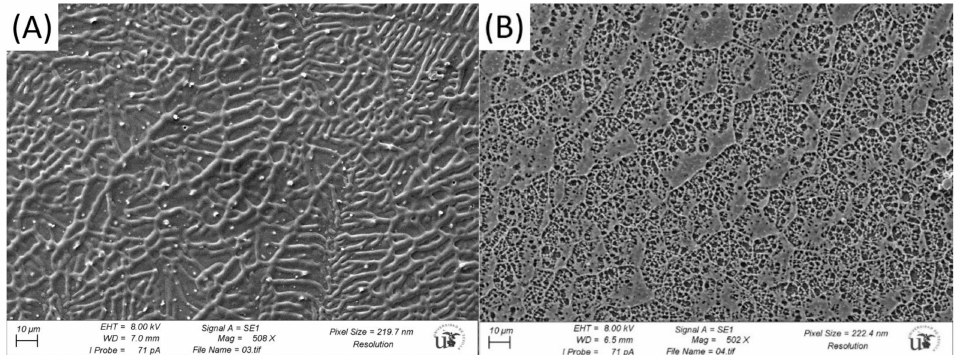
Figure 8. Representative Cryo-SEM micrographs for ( A ) the emulsion formulated with 0.25 g/100 g of advanced performance xanthan gum and ( B ) an aqueous solution that contains 0.25 g/100 g of advanced performance xanthan